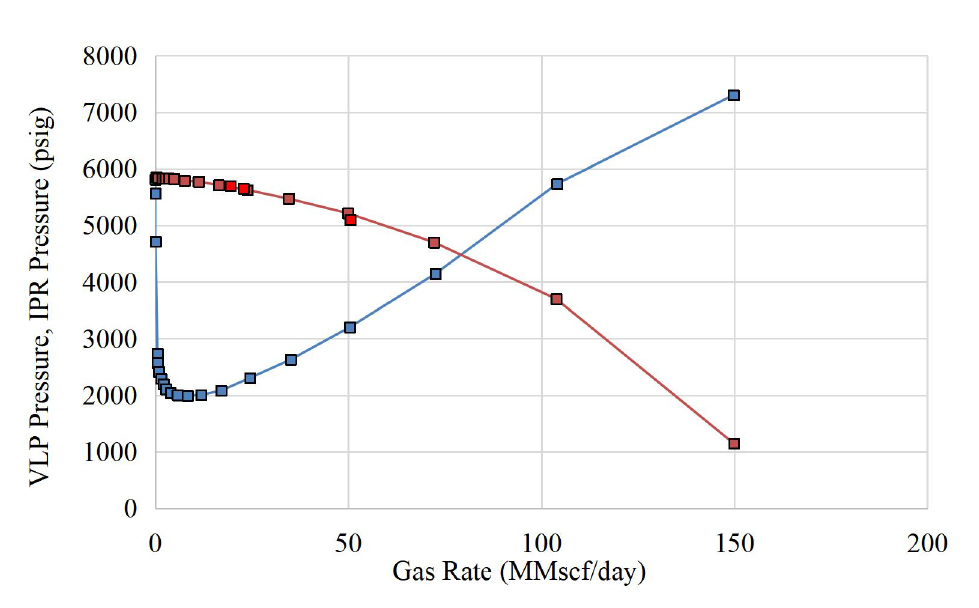
Figure 13—IPR & VLP Calculation